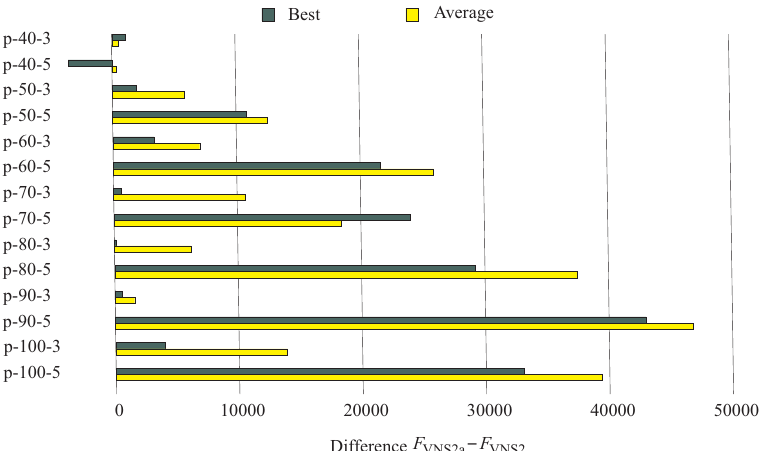
Figure 11. Difference in the solution values between VNS2a (that is, VNS2 with no swap operator) and the VNS2